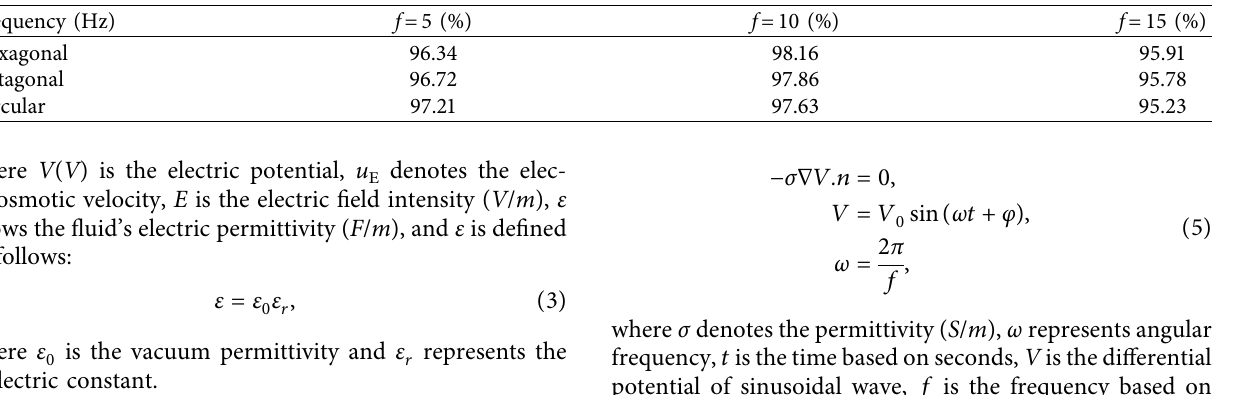
Table 5: Mixing efficiencies at t � 1 s for u � 0.1mm · s − 1 and φ � π /2 at different